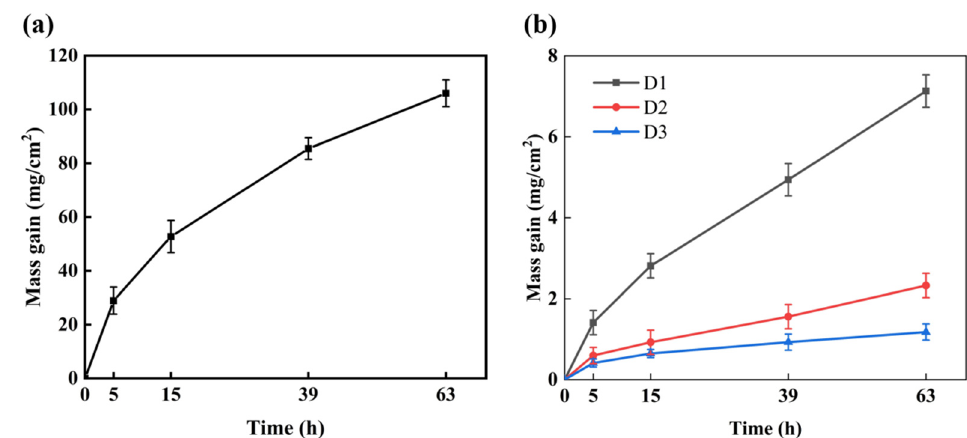
Figure 7. Relationship of weight gain of Q345 steel with oxidation time: ( a ) pure Q345 steel; ( b ) D1, D2, and D3 samples prepared by hot dipping and annealing.